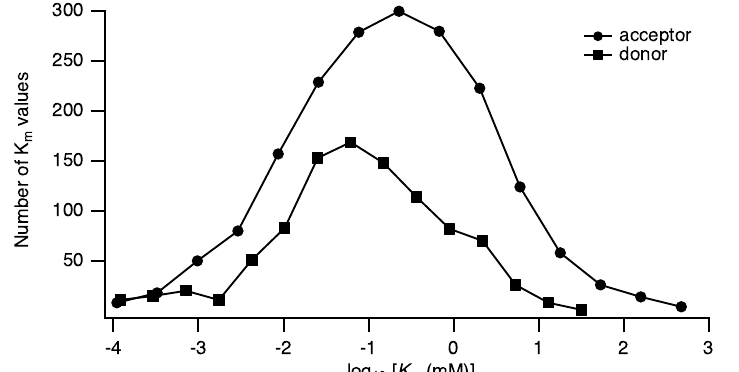
Figure 4. Distribution of K m values among the glycosyltransferases. The acceptor and donor substrates of the hexosyltransferases and sialyltransferases are seen to have distinct K m probability distributions, geometric means and geometric standard deviations (see text for details). Data are adapted from the BRENDA database